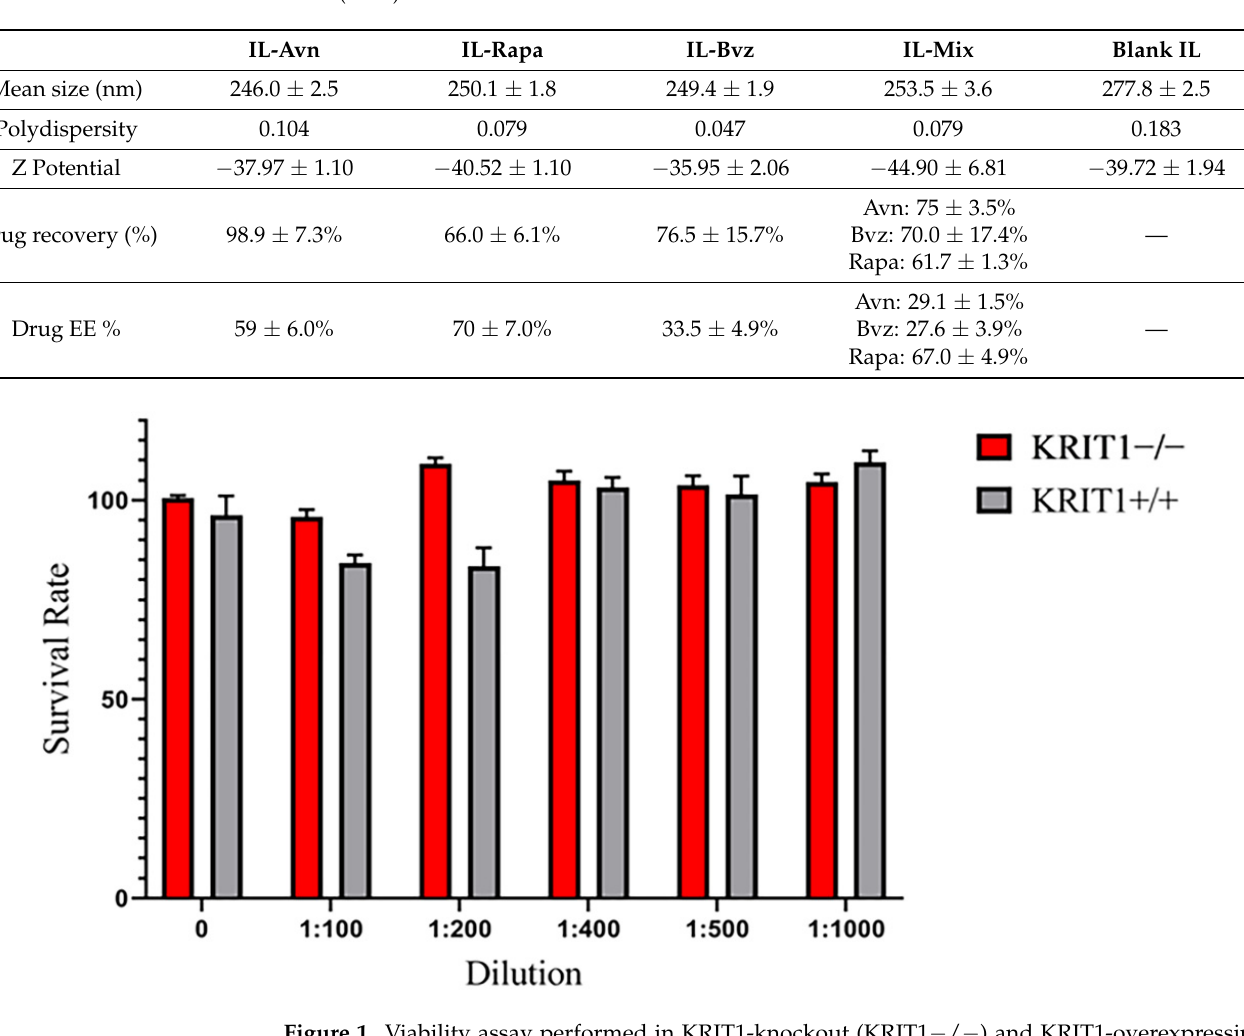
Figure 1. Viability assay performed in KRIT1-knockout (KRIT1 − / − ) and KRIT1-overexpressing (KRIT1+/+) mouse embryonic fibroblasts (MEFs) left untreated (NT) or treated for 24 h with injectable nanoemulsions (ILs) at different concentrations. After treatment, cell viability was measured as described in Section 2.6 of Materials and Methods, and the best dilution was used to develop the following